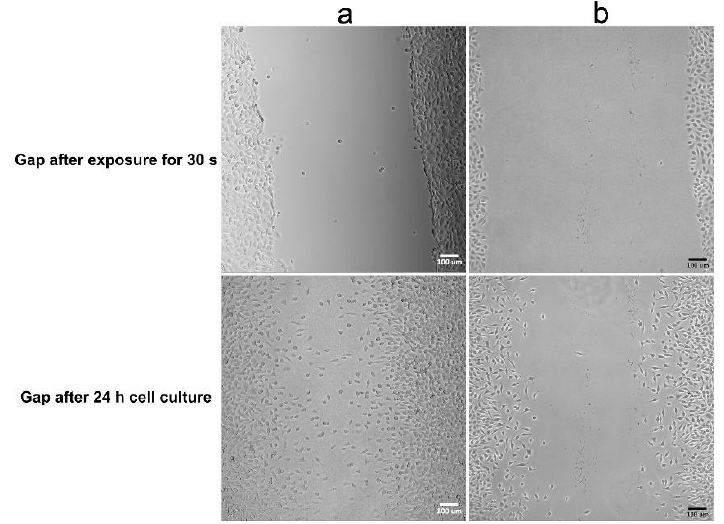
Figure 10. Images of fibroblast cells crossing a gel-covered area. A straight linear gap was created in a confluent L929 cell monolayer. The aqueous composite was placed within the gap area and irradiated for 30 s. Then cell migration was observed with ( a ) 90G10C containing 20% MBG gel, and ( b ) blank used as control.